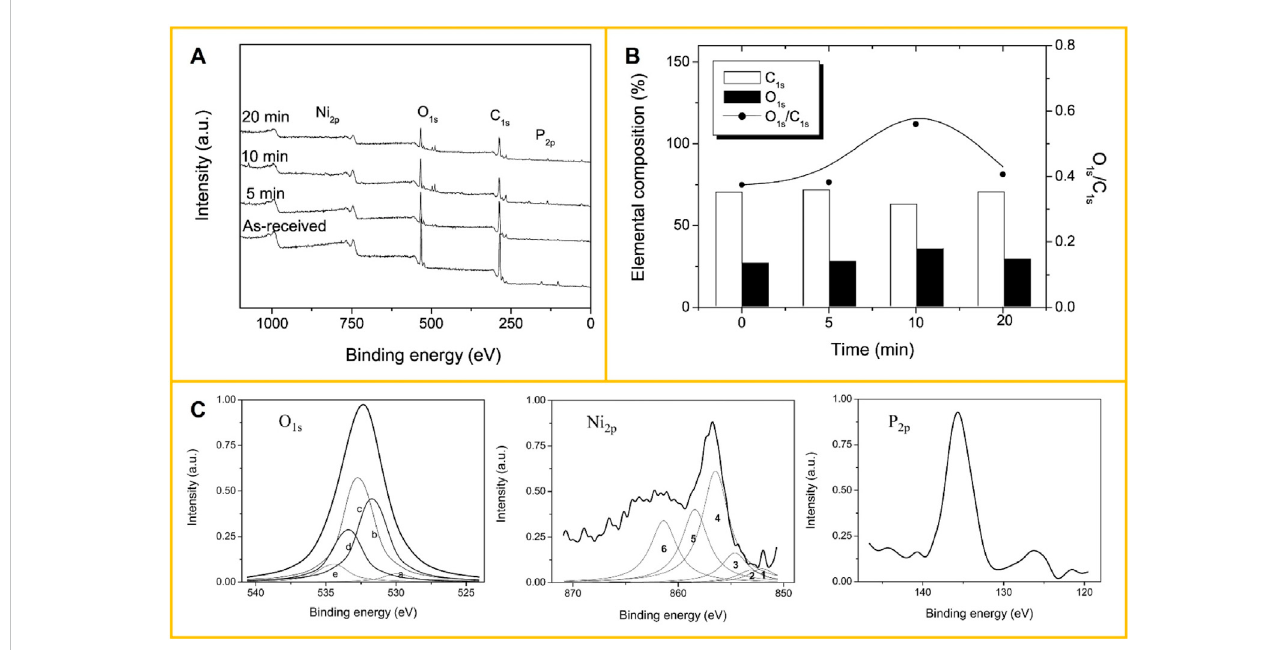
FIGURE 6 (A) XPS spectra of the Ni-P deposited carbon fi bers as a function of the plating time. Reprinted with permission from (Park and Jang, 2003). Copyright 2003 Elsevier Science (United States). (B) Elemental composition and O 1s /C 1s ratio of non-treated and nickel-plated carbon fi bers. Reprinted with permission from (Park and Jang, 2003). Copyright 2003 Elsevier Science (United States). (C) High-resolution spectra of O 1s , Ni 2p , and P 2p for the Ni-P deposited carbon fi bers (10 min): (a) NiO, (b) C=O or -OH, (c) O-C-O, (d) P 2 O 5 , (e) -C-O; (1) Ni metal, (2) Ni-P (Ni 2 P, NiP 2 , etc.), (3) NiO, (4) Ni-C, (5) Ni metal, and (6) Ni 2 O 3 groups. Adapted with permission of (Park and Jang, 2003). Copyright 2003 Elsevier Science (United